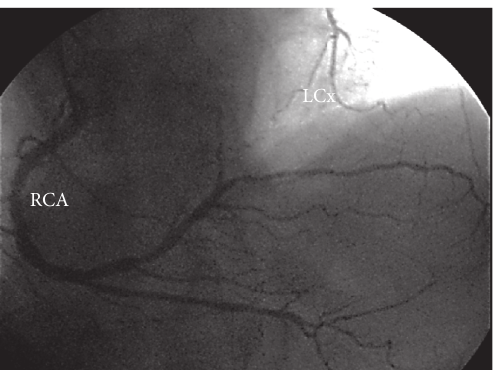
Figure 1: Selective contrast injection in the dominant RCA, showing ectasias and diffuse discrete lesions and a moderate narrowing at the proximal portion of the right posterolateral branch, and the well developed collateral circulation to the LCx. RCA: right coronary artery; LCx: left circumflex.